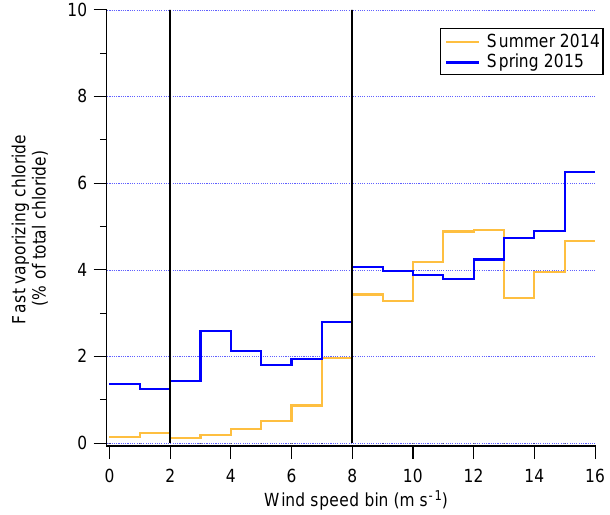
Figure 8. Fast-vaporizing chloride as a percent of total chloride measured (modeled) in the AMS as a function of wind speed for both the spring–summer field season (gold) and winter–spring field season